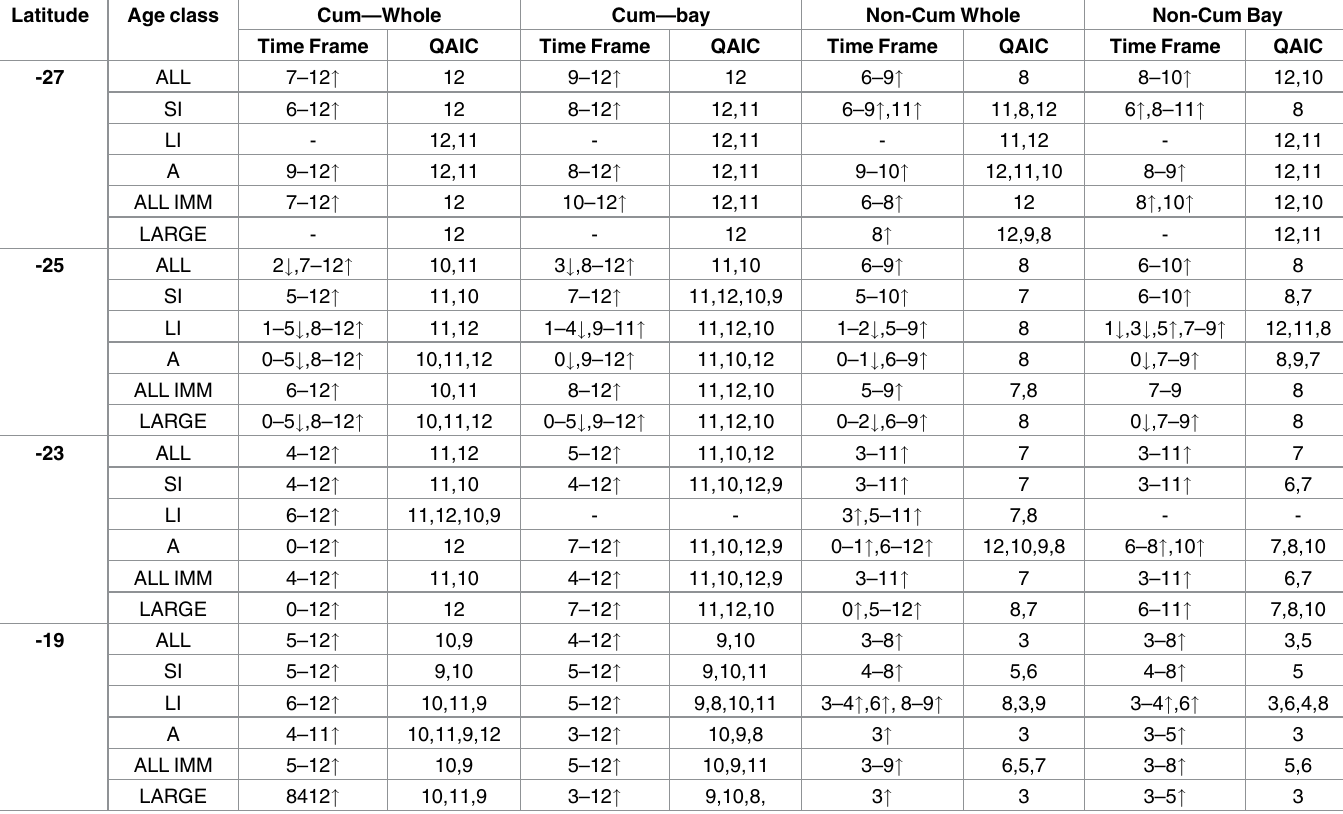
Table 5. Model results for green turtles and peak discharge. " denotesincreasedstrandings rates with increaseddischarge. # denotesdecreased strand- ing rates with increaseddischarge.Age class abbreviations:ALL = all turtles, SI = small immature, LI = large immatures, A = adult-sized,ALL IMM = all imma- ture sized animals(small + large), Large = all large turtles (large immatures + adult-sized). The time frame is reportedin monthly ranges where responses were noted. The values reportedin qAIC are the months with the most significantqAIC